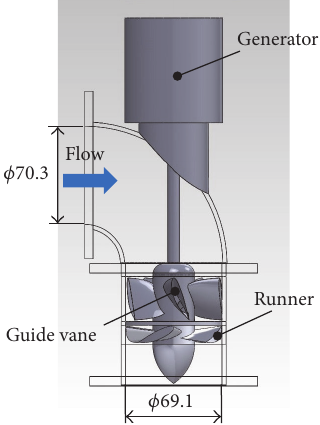
Figure 3: Ultra-small axial flow hydraulic turbine.